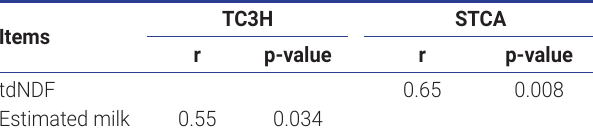
Table 6. Correlation between FTIR carbohydrate structures and the energy profile of canola meals